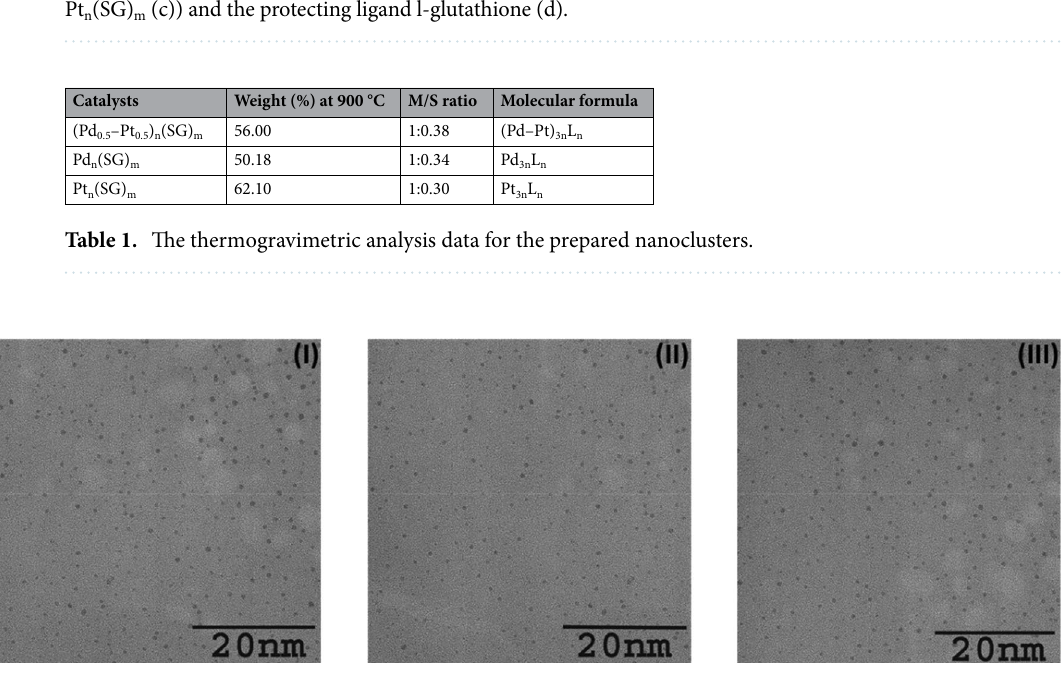
Figure 1. ( I ) UV–Vis absorption spectra of the prepared nanoclusters (Pd 0.5 –Pt 0.5 ) n (SG) m (a), Pd n (SG) m (b), and Pt n (SG) m (c). The prepared clusters show featureless absorption curves in the visible region of 350–900 nm. ( II ) The thermogravimetric analysis (TGA) of the prepared clusters ((Pd 0.5 –Pt 0.5 ) n (SG) m (a), Pd n (SG) m (b), and Pt n (SG) m (c)) and the protecting ligand l-glutathione (d).